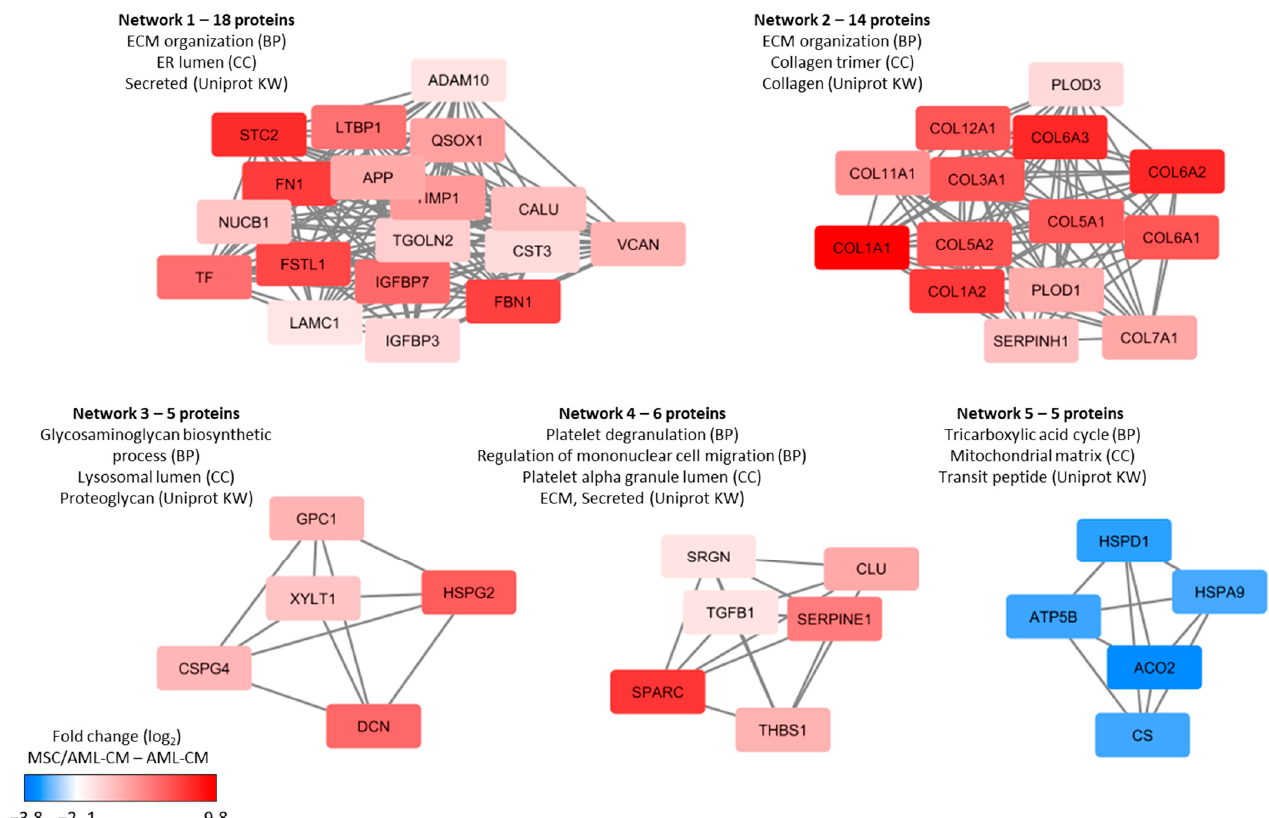
Figure 7. Densely connected protein networks based on proteins which were two-fold increased or four-fold decreased in the MSC/AML-CM culture supernatants compared to AML-CM (i.e., corresponding AML cells cultured alone). Proteins with significantly altered protein abundance were imported to String for protein interaction network analysis. The protein networks were further imported to Cytoscape where the MCODE application was used to find closely connected protein networks containing at least five proteins. The GO annotations were identified by the String database. Red color indicates increased abundance in MSC/AML-CM and blue color indicates decreased abundance in MSC/AML-CM relative to AML-CM. BP, biological processes; CC, cellular compartment; Uniprot KW, Uniprot Keywords; ECM, extracellular matrix; ER, endoplasmic reticulum.